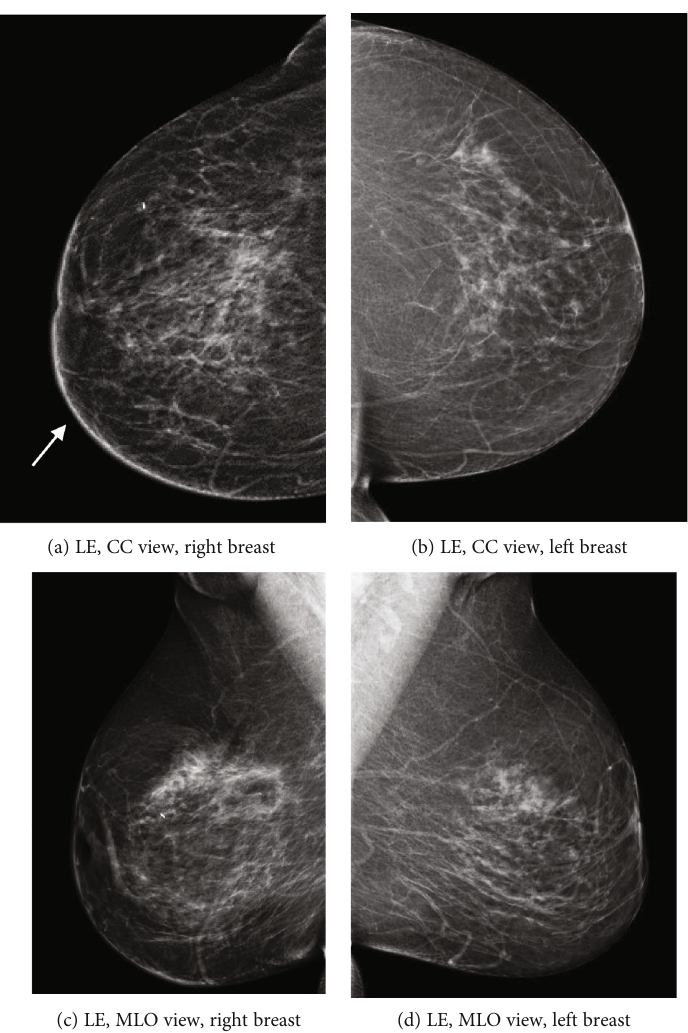
Figure 1: (a – d) Bilateral LE images in a craniocaudal (CC) and medial oblique (MLO) views. Posttreatment changes at the right inner breast are best appreciated on the CC view (arrow, (a)). A separate tissue marker is demonstrated in the right upper outer quadrant is related to a previous benign